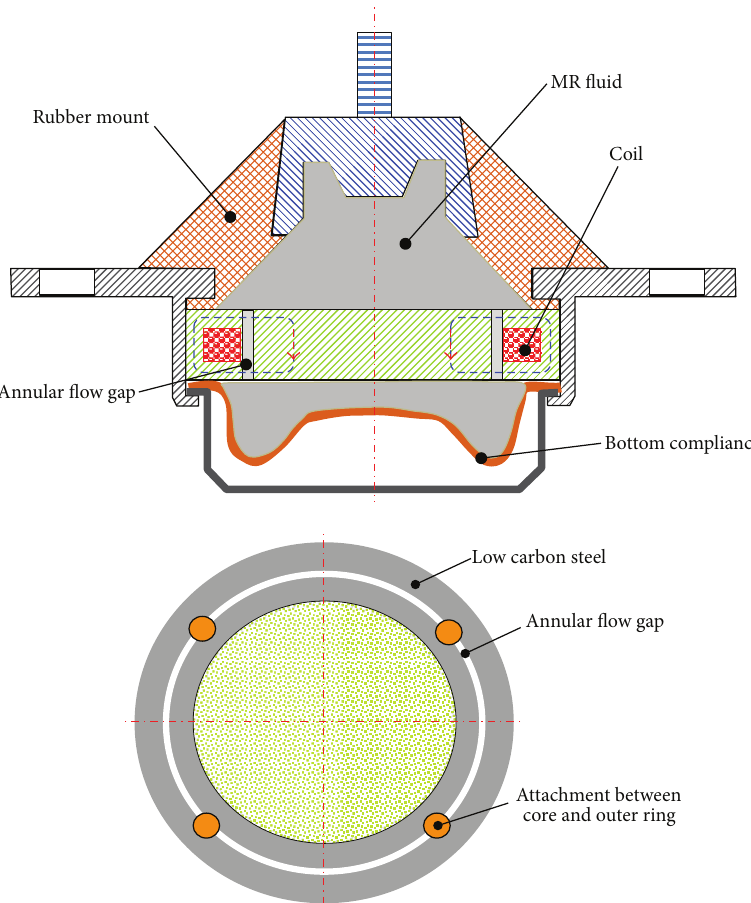
Figure 21: Cross section of MR mount based on hydraulic